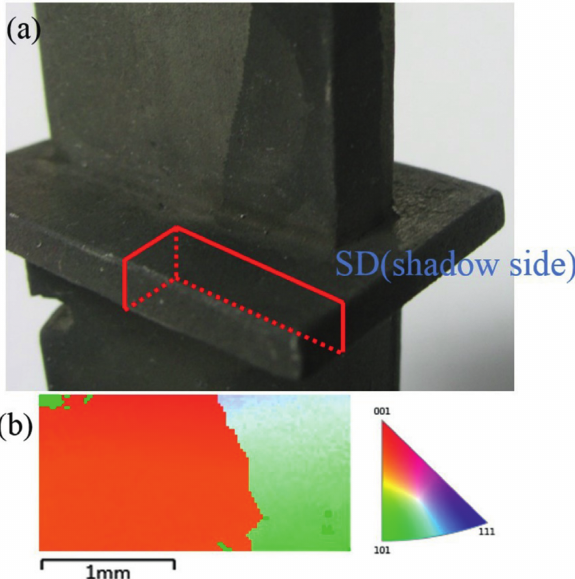
Figure 4: For sample A3, (a) the location of cut specimen for EBSD measurement and (b) corresponding orientation map of inner face of it.